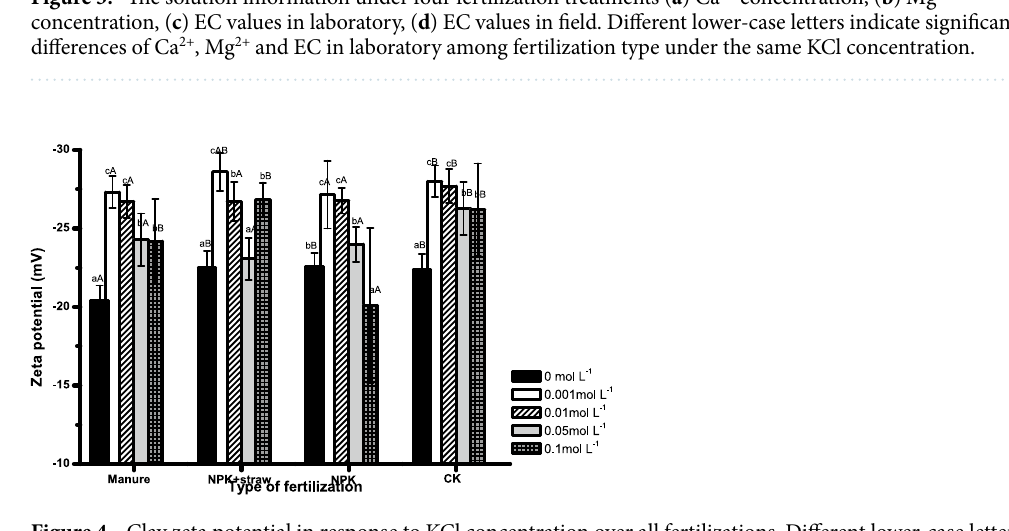
Figure 4. Clay zeta potential in response to KCl concentration over all fertilizations. Different lower-case letters indicate significant differences with concentration under each type of fertilization. Different capitalized letters indicate significant differences among the four types of fertilization at the same